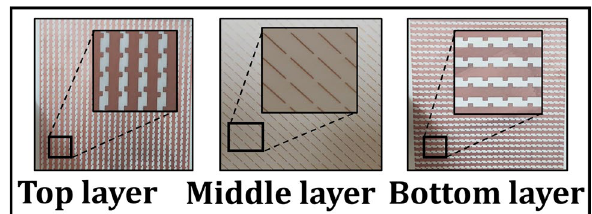
Figure 14. Fabricated prototype of the multi-layered design.